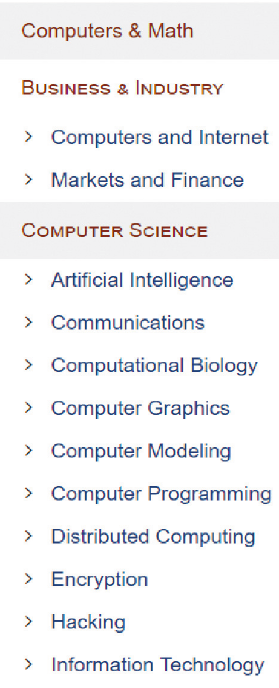
Figure 1: Part from field